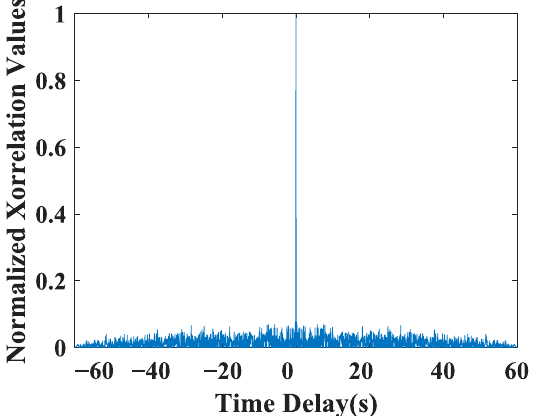
Figure 1. Correlation results of the BPSK signal model.